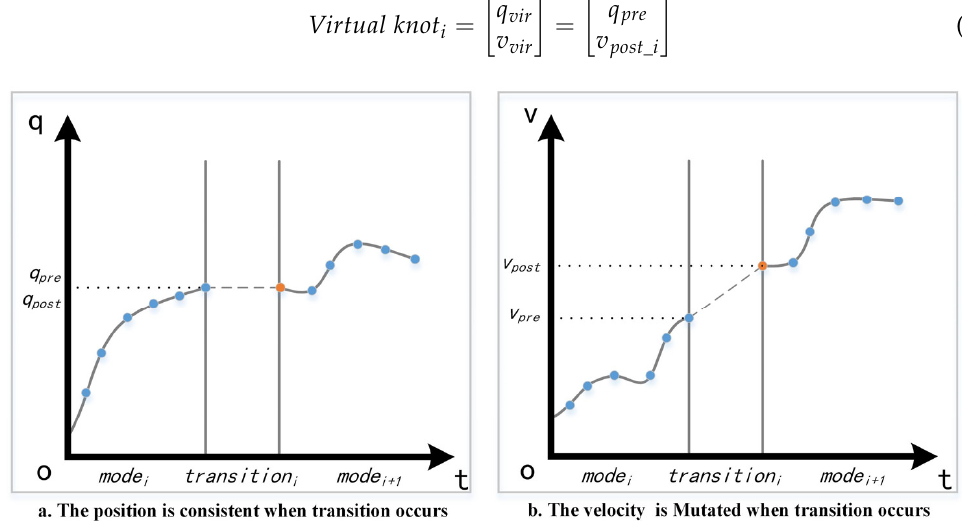
Figure 1. The virtual knot insertion between two adjacent modes where robot state transition occurs when the swing foot contacts the ground. The blue points are the original knot and the orange points are the inserted virtual knot.